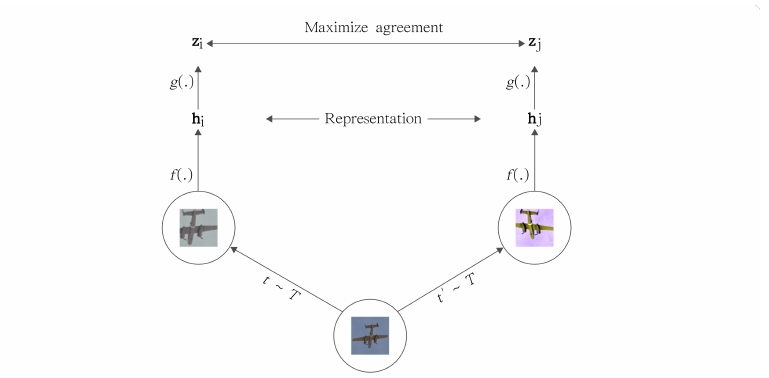
Figure 17. SimCLR Architecture (https://sthalles.github.io/simple-self-supervised-learning/), ac- cessed on 15 September